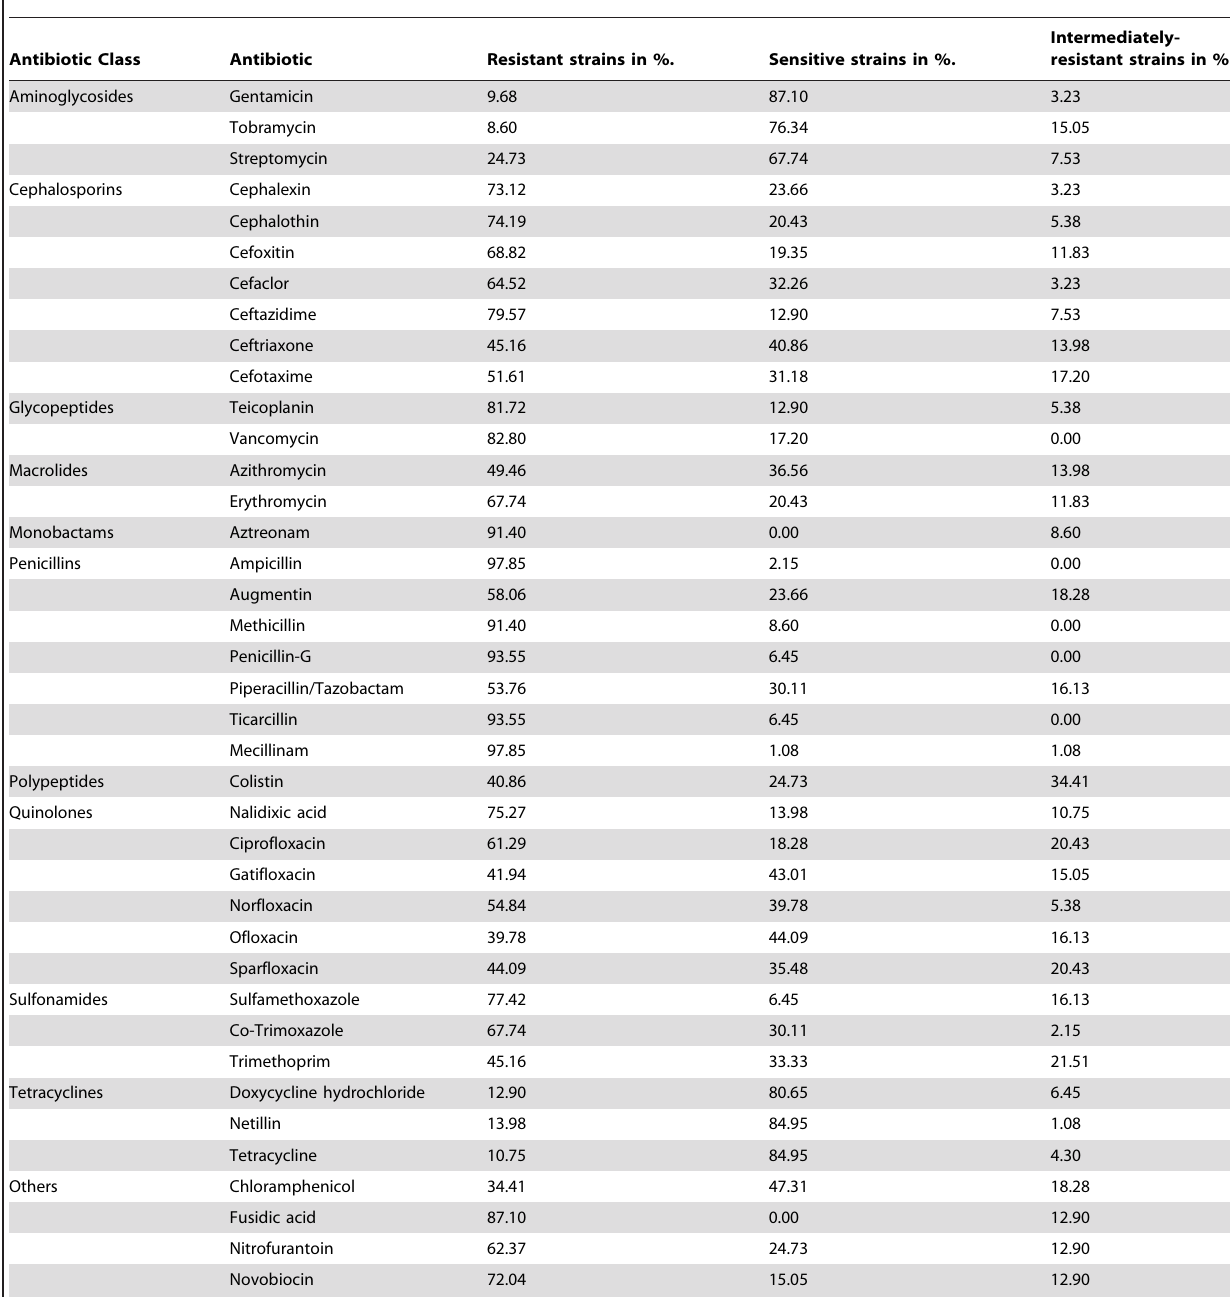
Table 3. Distribution of resistance among the strains from PETL WWTP against different antibiotics.